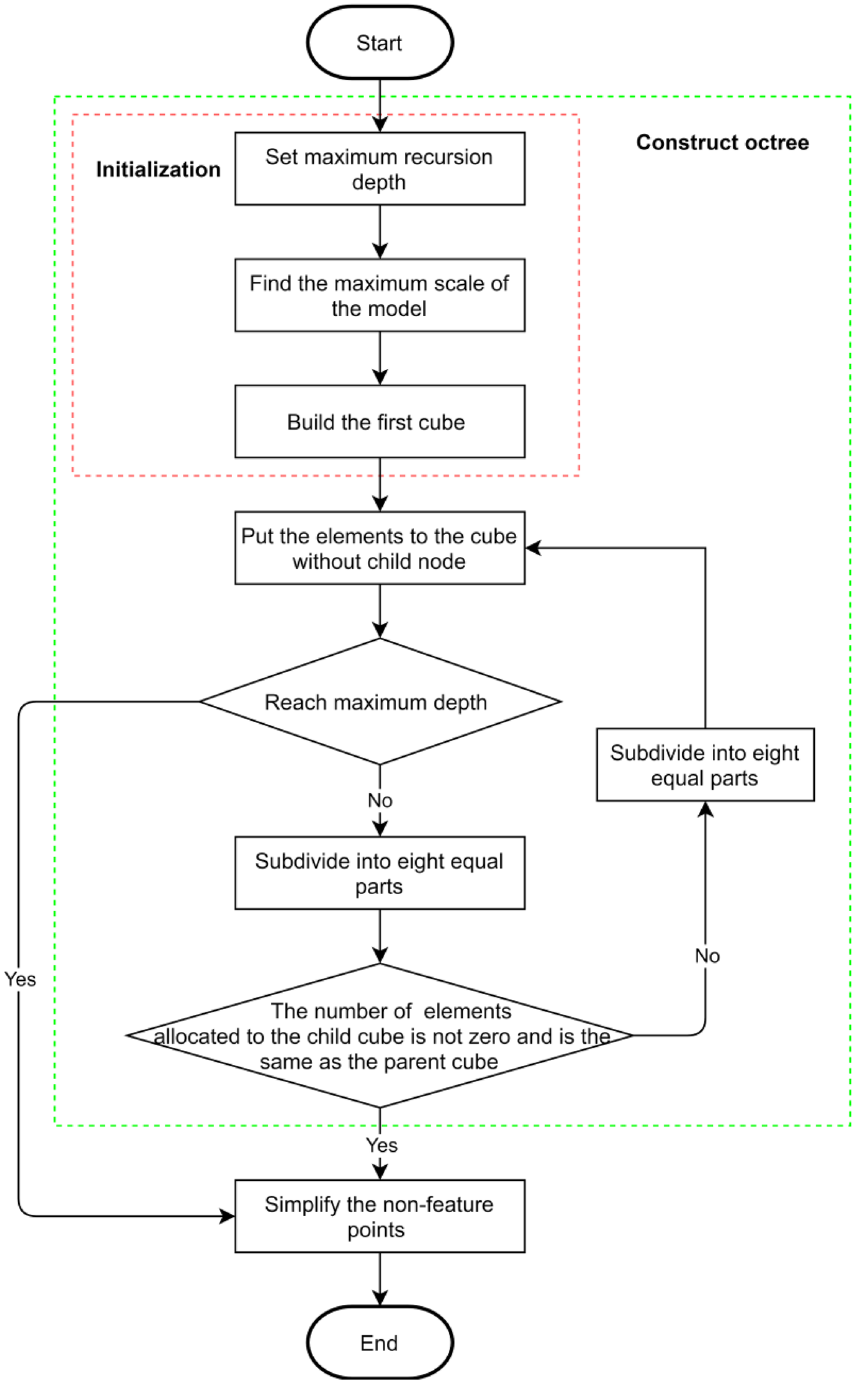
Figure 19. The flowchart of the non-feature point